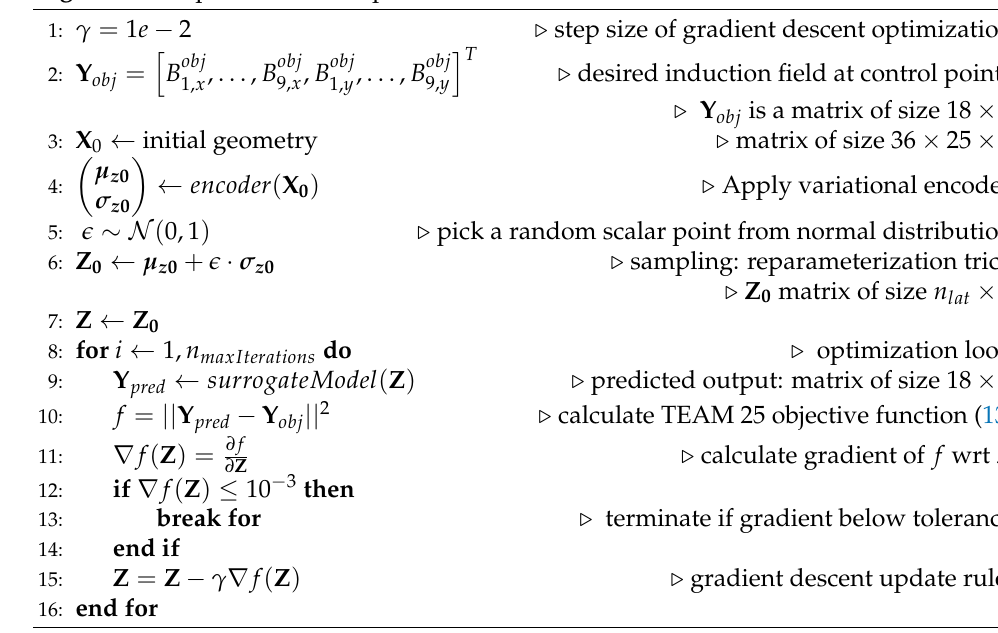
Algorithm 2 Optimization Loop